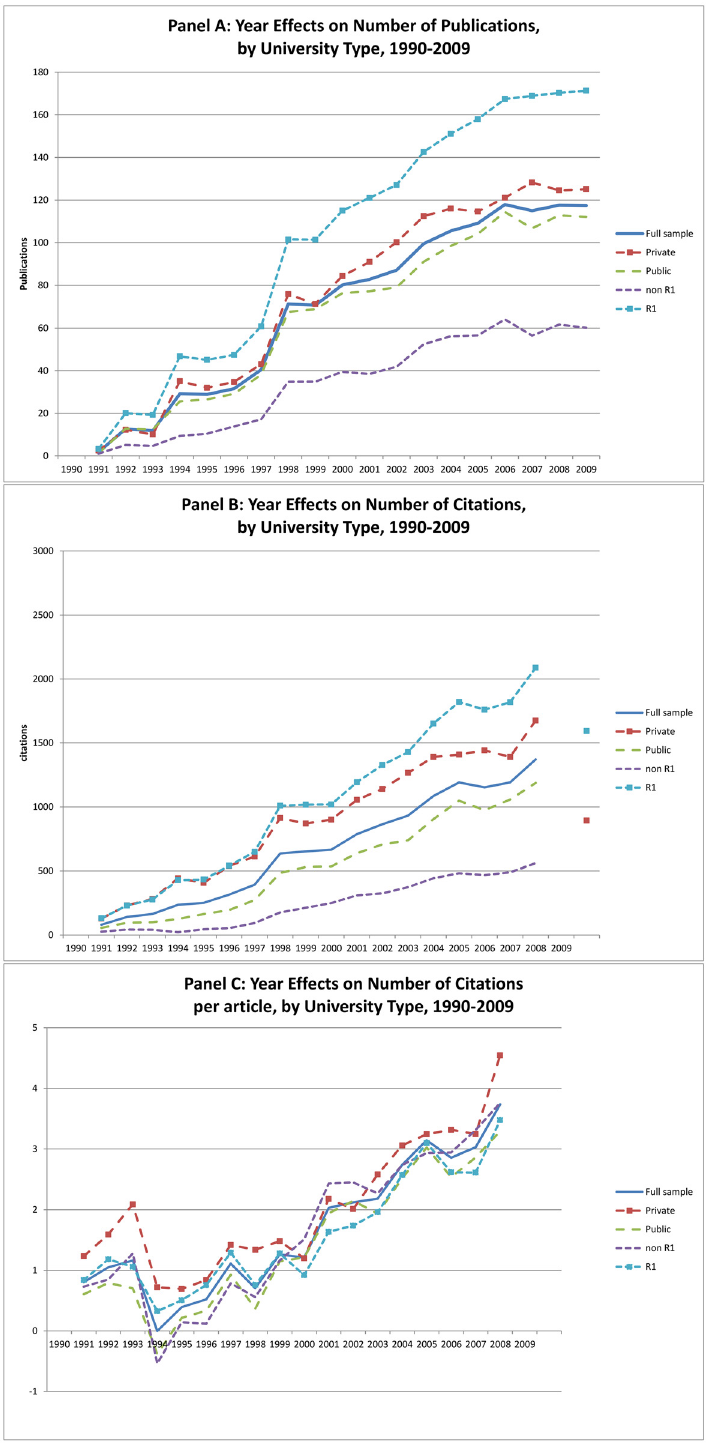
Fig 6. Year Effects from OLS Regression: Number of Publications, Number of Citations and Number of Citations per